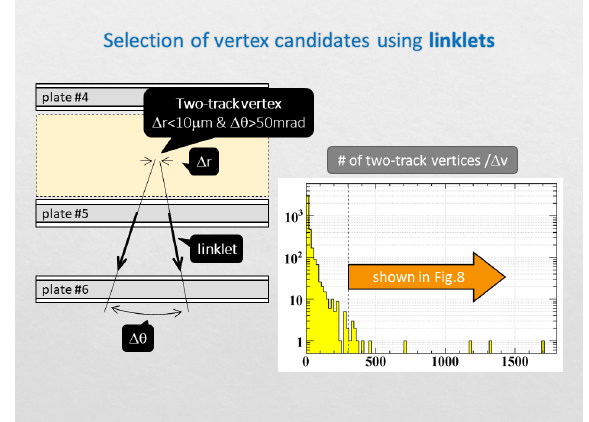
Fig 2. Structure of a RUNJOB chamber for the 1997 flight. Fig 4. A schematic picture of micro-tracks related to the cosmic Fig 5. An example of “slipping”. Relative position between ray interaction in Fig.3. Precise relative position among emulsion emulsion plates had been moving, most probably while the plates are lost after they were de-packed and developed. chamber was in its balloon flight.